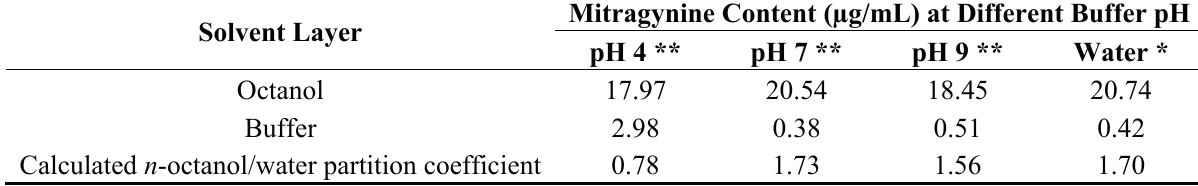
Table 3. The n -octanol-water partition coefficient of mitragynine.